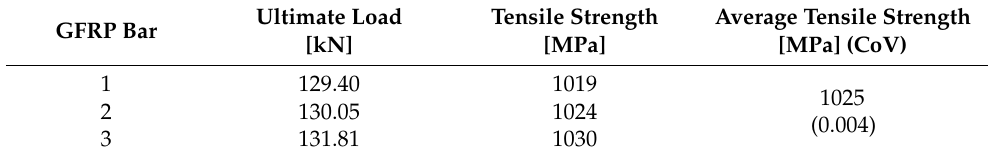
Table 1. Results of the tensile tests of GFRP bars.